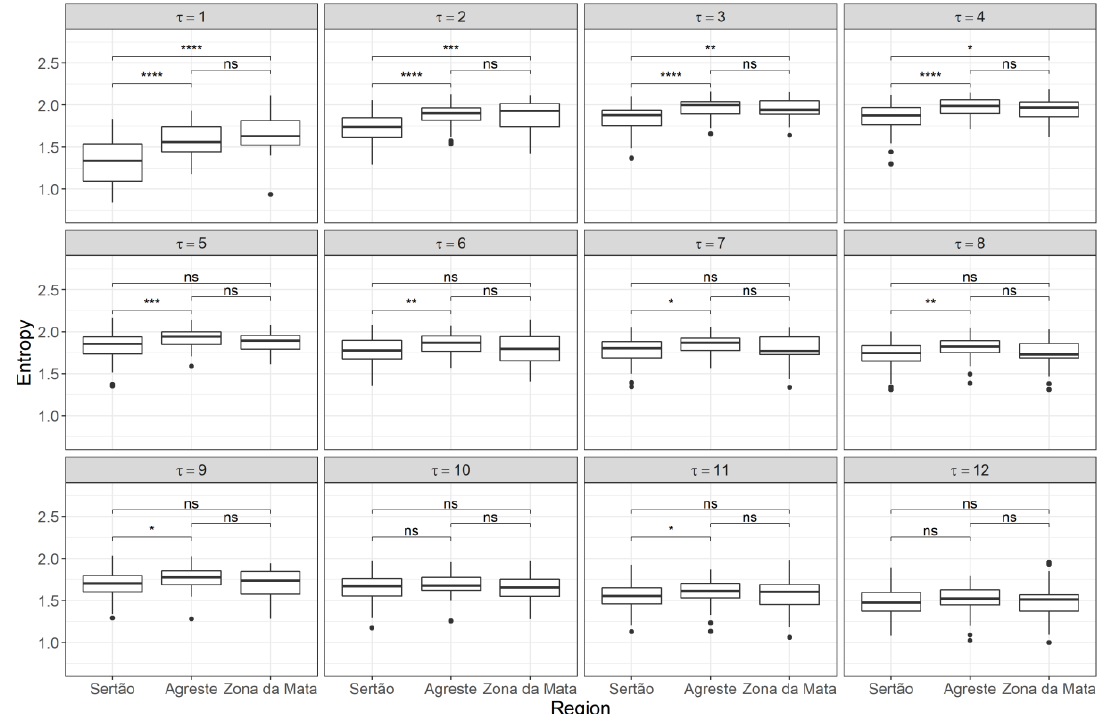
Figure 9. Boxplots for MMSE values (anomalies series) for the regions of Zona de Mata, Agreste, and Sertão for τ = 1, 2, …, 12. “*”, “**”, “***”, “****” indicate that there is a significant difference between the regions at the 5%, 1%, 0.1%, 0.01% significance level, respectively; “ns” means not significant.